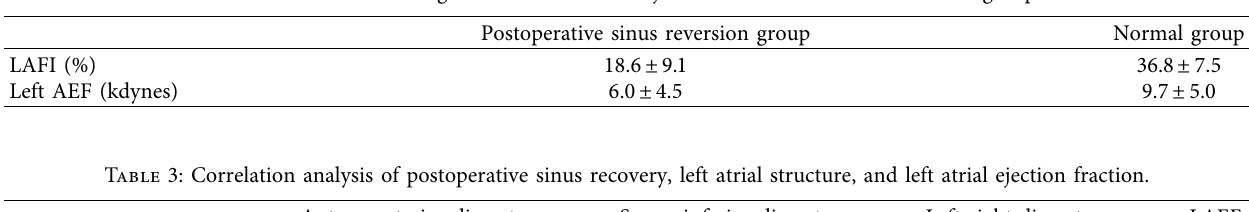
Table 2: Left atrial filling index and left atrial ejection force in the sinus reversion group.